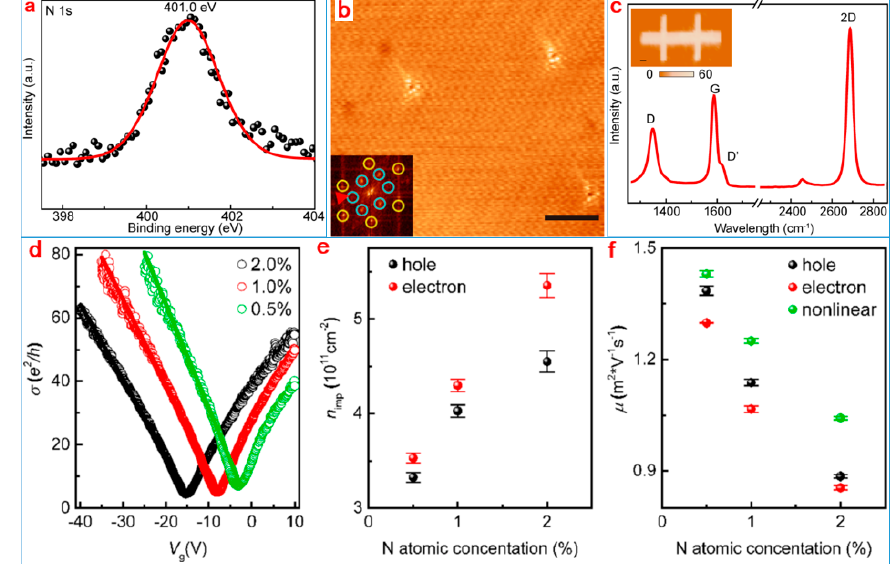
Figure 4. ( a ) N 1s core-level XPS (X-ray photoelectron spectroscopy) spectra of an as-formed graphitic N-doped (2% N atomic concentration) graphene film. ( b ) Scanning tunneling microscope (STM) image of an as-formed graphitic N-doped graphene sample ( V bias = − 10 mV and I set = 100 pA ). ( c